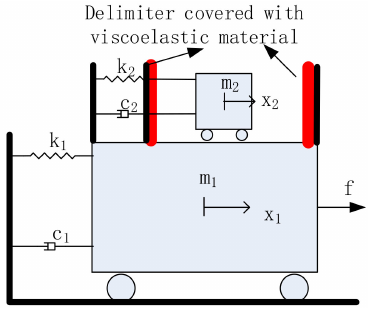
Figure 1. Schematic of the